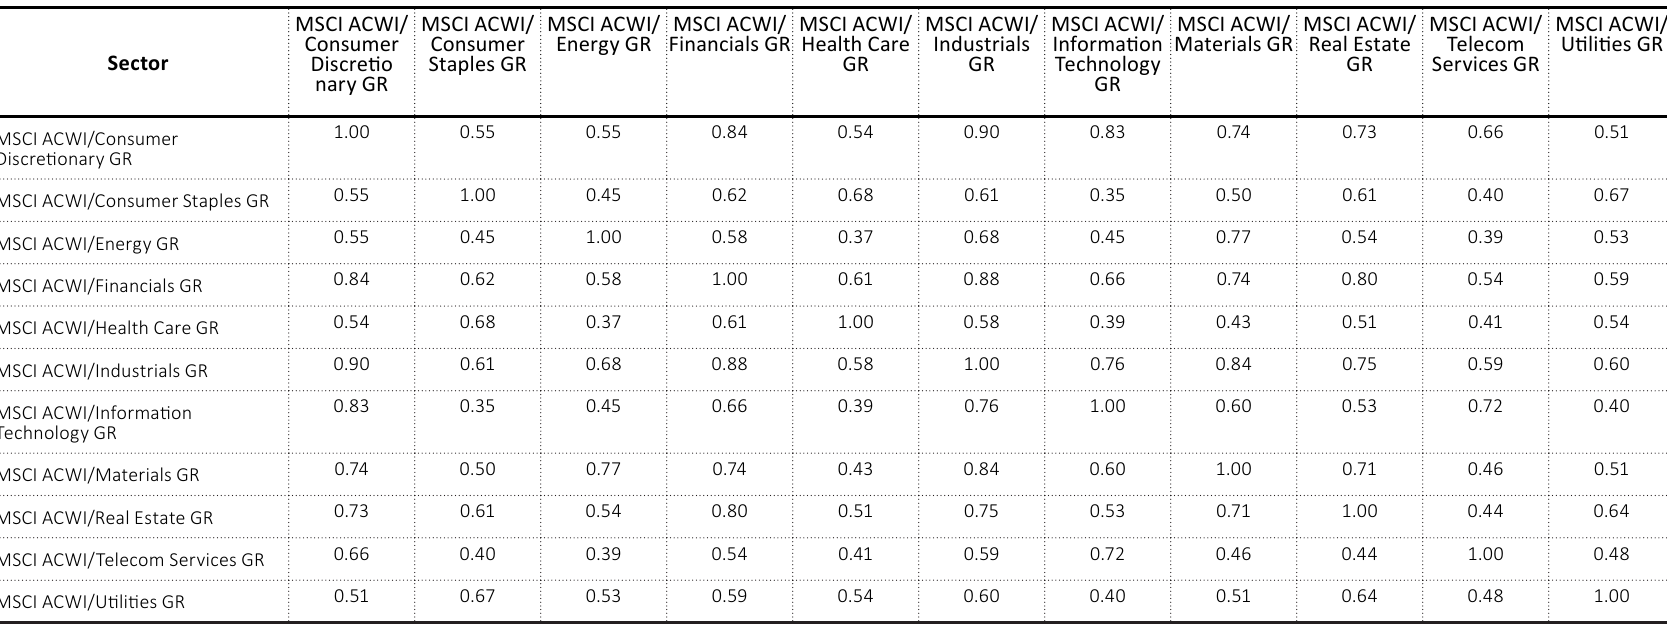
Table 4. The correlation matrix of the geographic benchmarks’ excess returns Geographic MSCI Emerging Markets GR